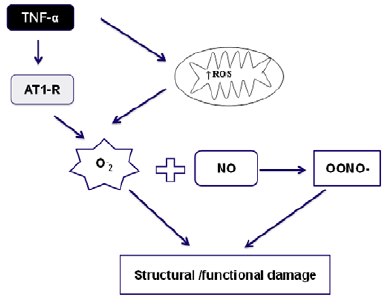
Figure 7. Schematic diagram showing TNF-induced mitochon- drial